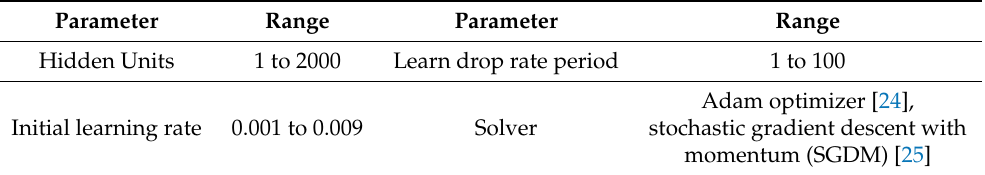
Table 2. Parameters used for developing LSTM-NN forecasting